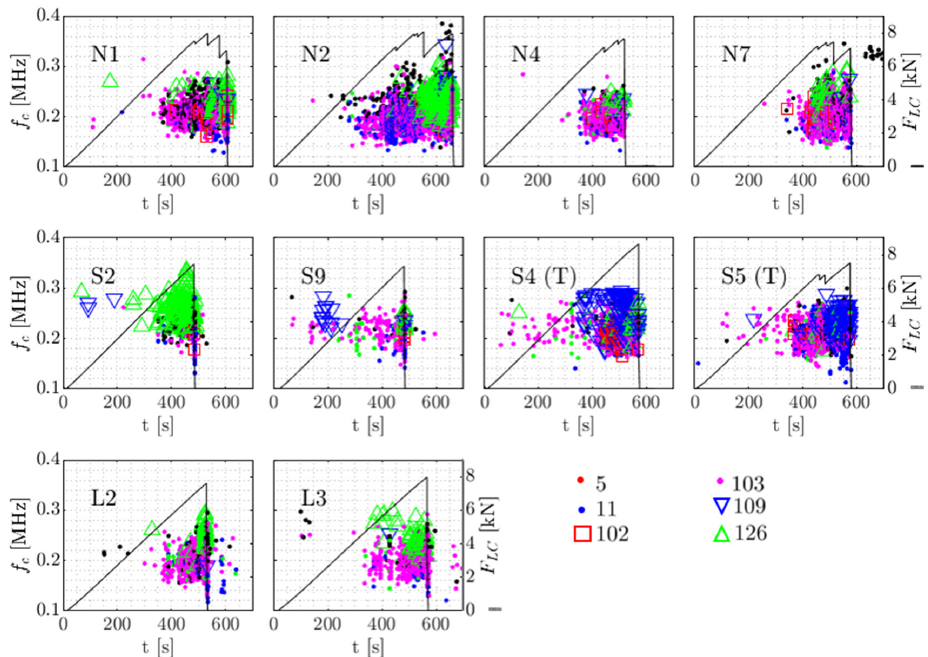
Figure 15. The AE clusters for each specimen, centroid frequency f c of the waveforms in the clusters and the applied load F LC .